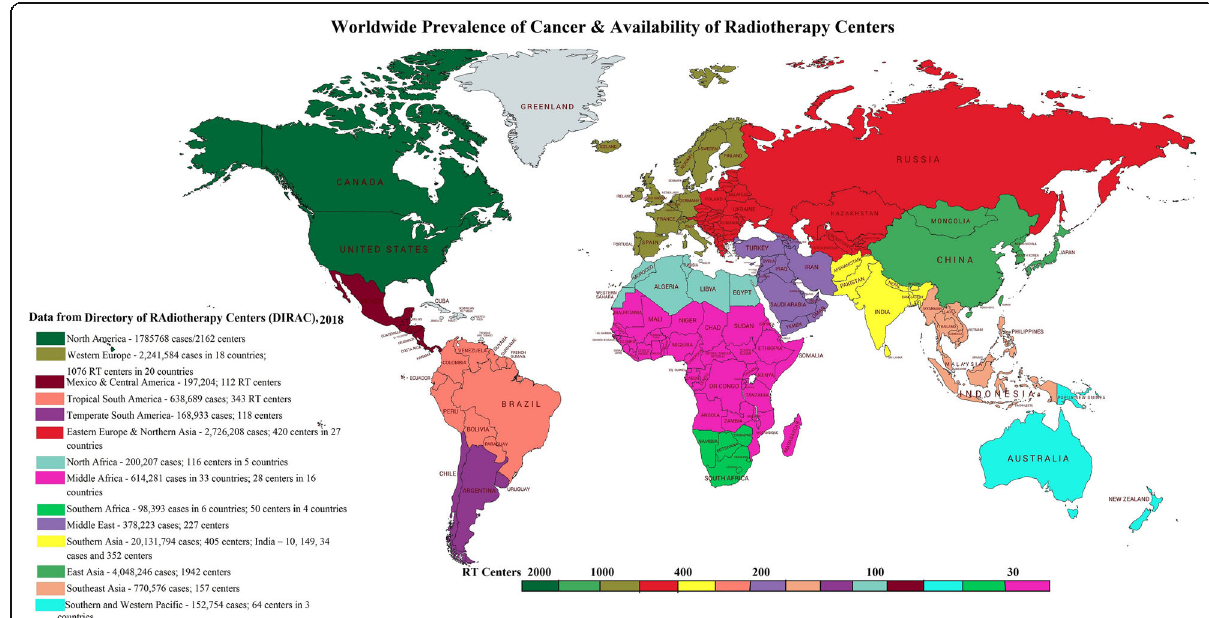
Fig. 1 Worldwide prevalence of cancer and availability of radiotherapy centers. Estimation of cancer incidence and availability of radiotherapy services worldwide as determined by the Directory of Radiotherapy Centres (DIRAC) database as per 2018. The color bar shows the number of radiotherapy centers available in various